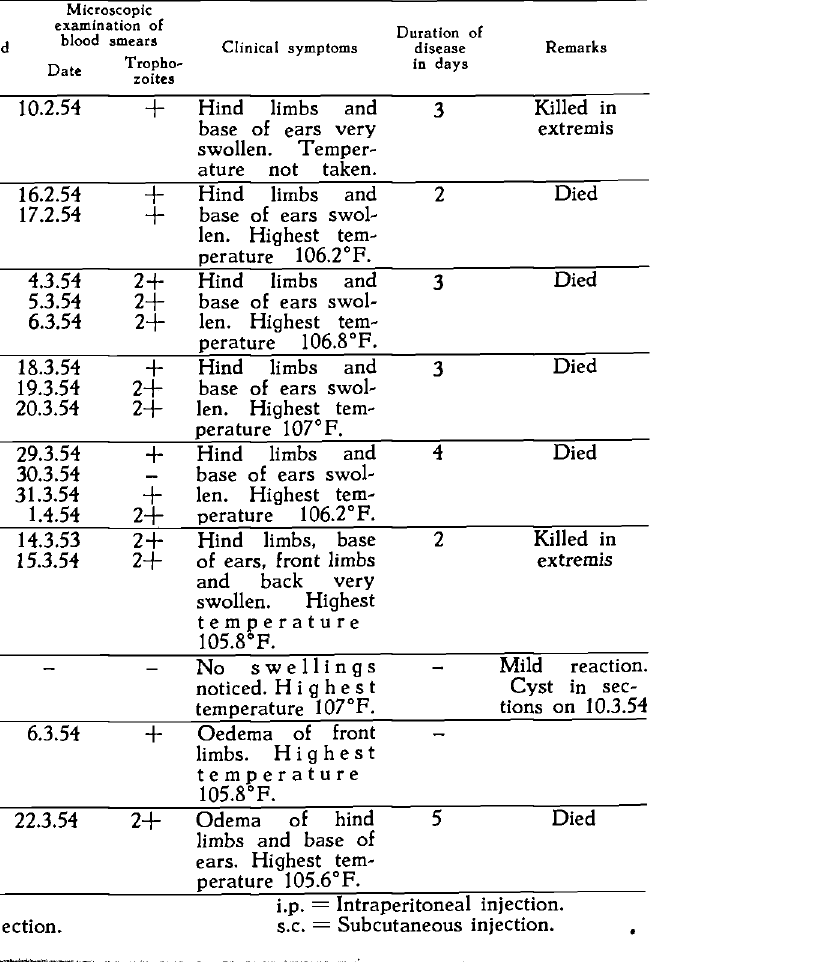
SERIAL PASSAGE OF GL. BESNOITl IN RABBITS AND